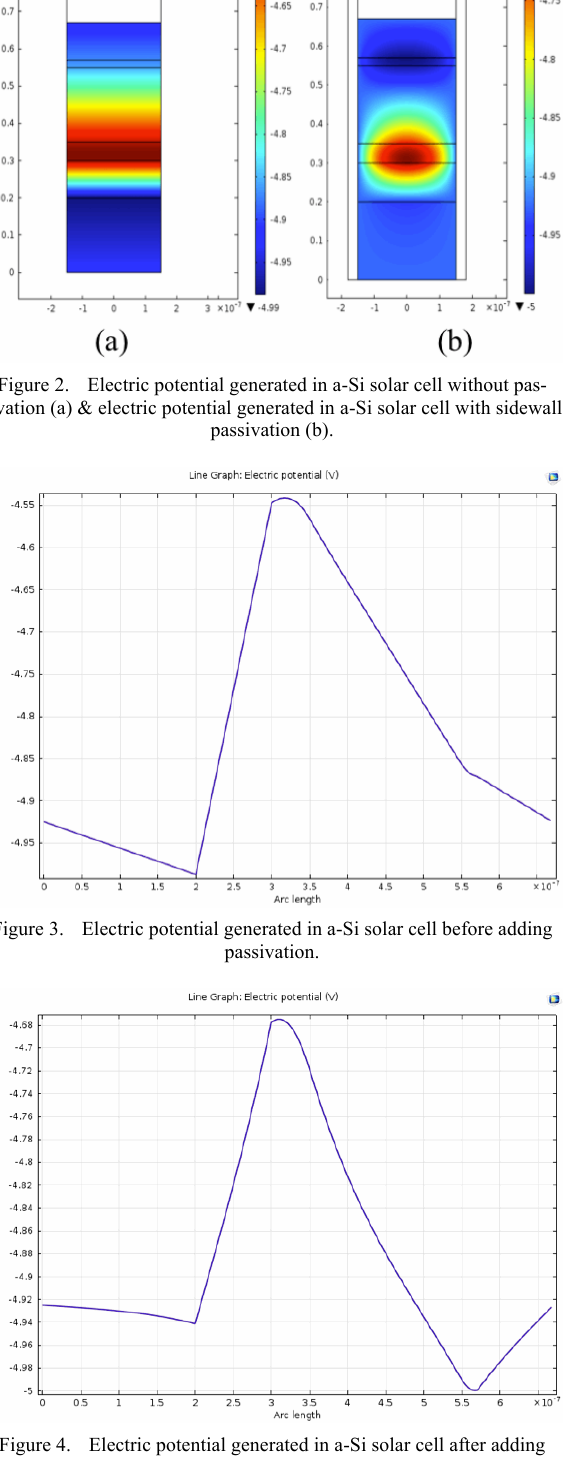
Figure 4. Electric potential generated in a-Si solar cell after adding sidewall